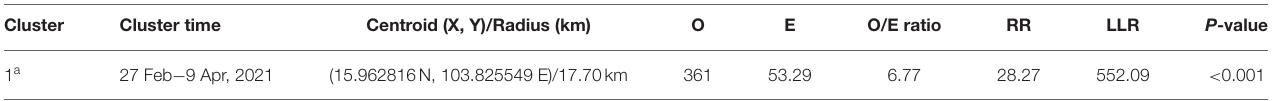
TABLE 5 | Spatio-temporal clusters by Poisson space-time scan statistic model on lumpy skin disease outbreaks in cattle farms in Roi Et, Thailand 2021. Cluster Cluster time Centroid (X, Y)/Radius (km) O E O/E ratio RR LLR P -value